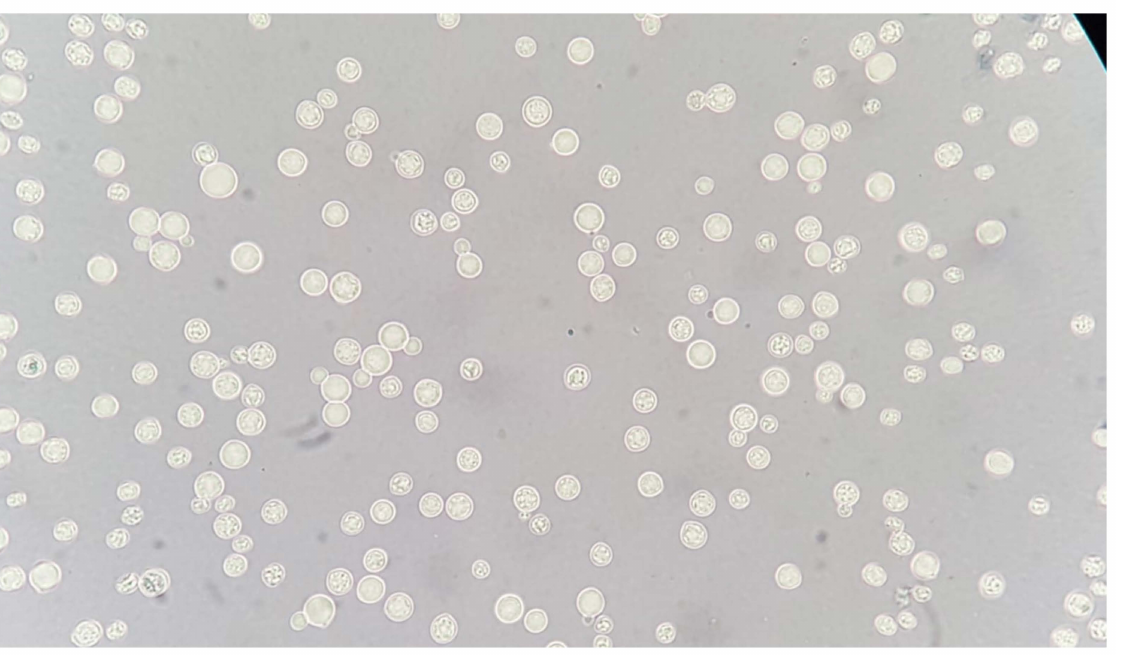
Figure 1. Chinese ink stain on CSF